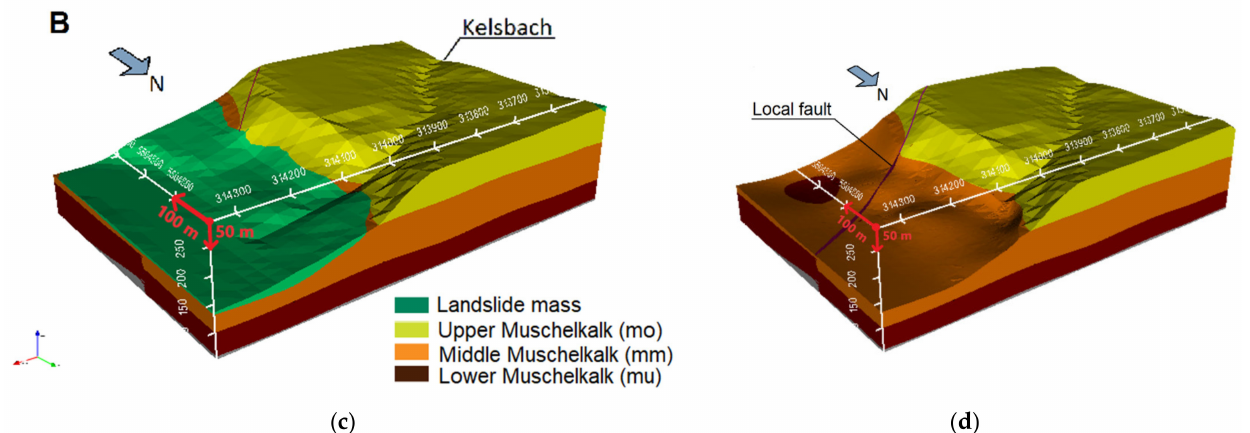
Figure 1. ( a ) Regional location of the study area (modified after [41]), ( b ) hillshade map showing location of the study area affected by the landslide in the Mosel River valley, a 3D geological model of the study area ( c ) with and ( d ) without landslide mass cover (processed from